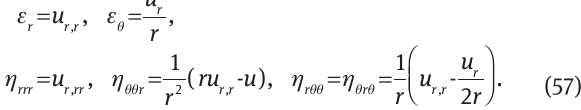
plane strain conditions apply and all the components of strain and strain gradient associated with the axis coor- dinate are zero.